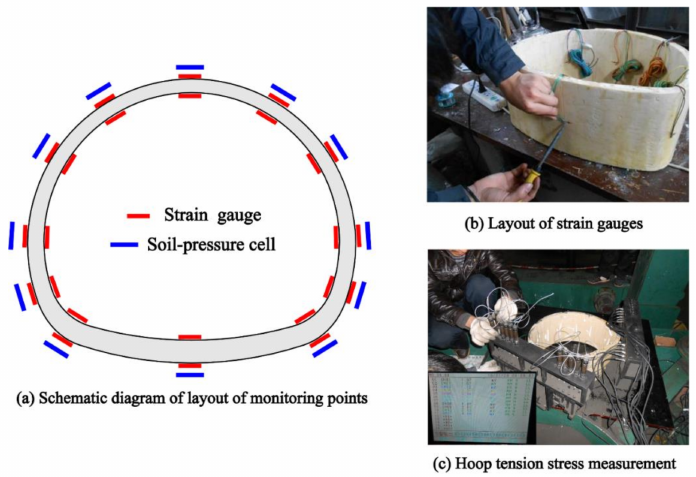
Figure 7. Measurement